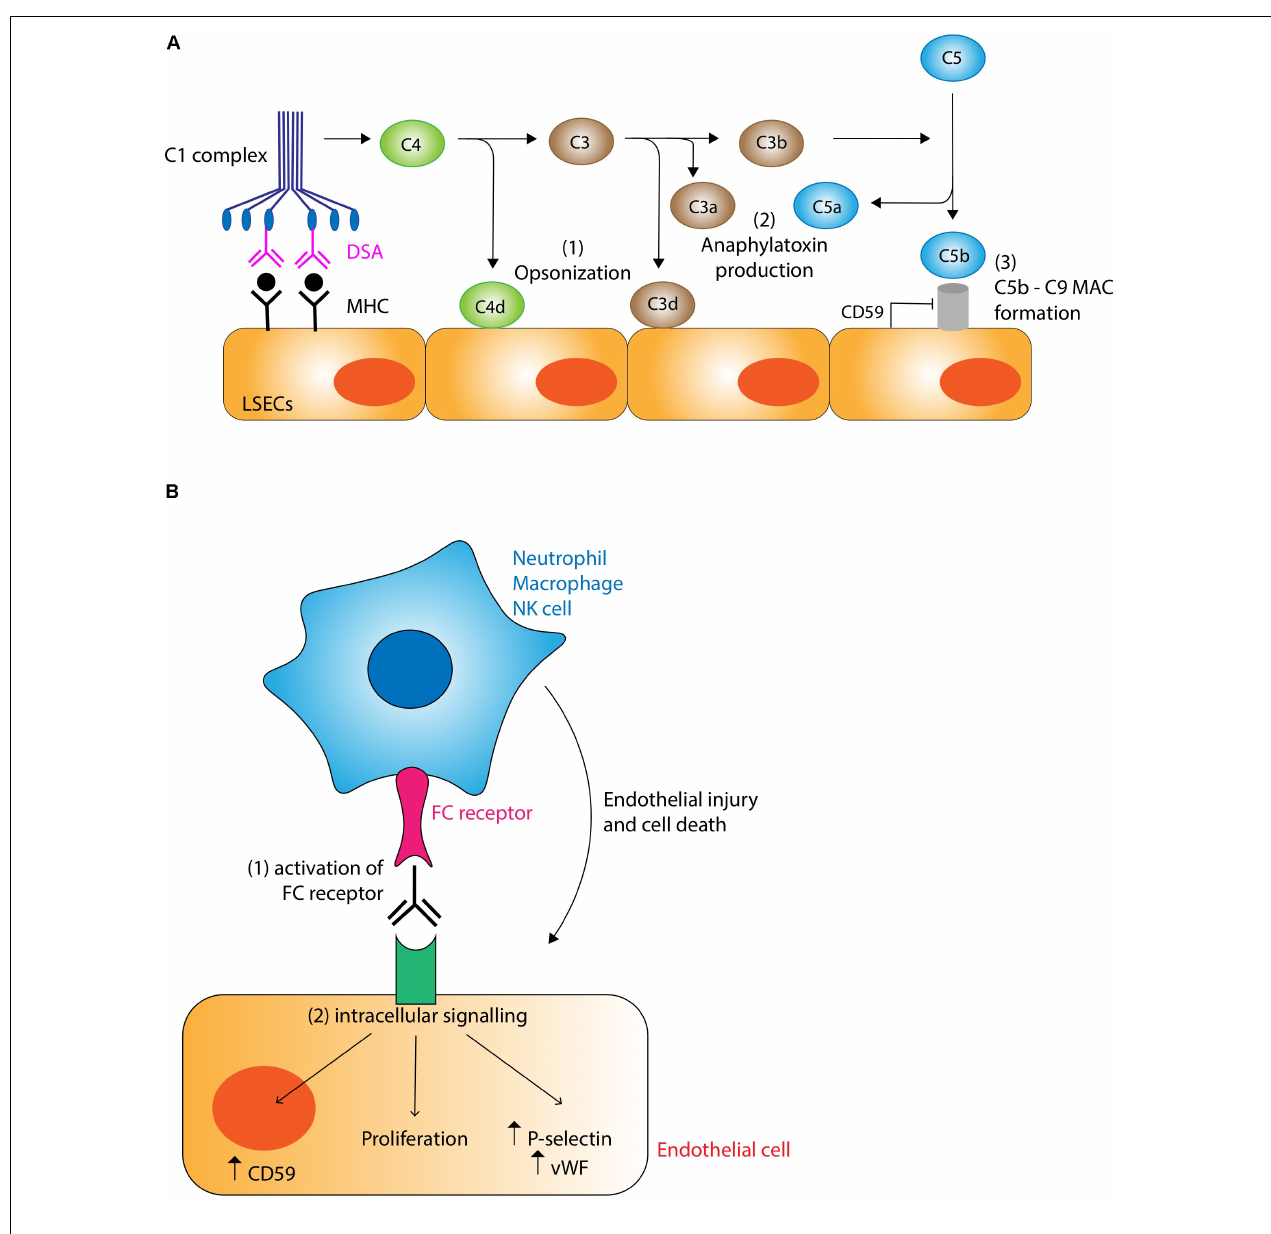
FIGURE 3 | (A) Complement-dependent mechanisms of antibody mediated rejection. Binding of donor specific antibody (DSA) to MHC molecules on the liver allograft causes activation of the classical pathway of complement via binding of the C1 complex. Complement has the potential to damage the graft through three main mechanisms: (1) Opsonization. C4d and C3d covalently bind to target cells marking them for destruction and clearing by cells of the innate immune system. (2) Anaphylatoxin production. C3a and C5a act as potent chemotactic signals recruiting inflammatory cells which cause localized tissue damage. (3) Membrane attack complex (MAC). The C5b-9 MAC has the potential to damage cells by puncturing holes in the membrane, although this action is normally inhibited by endothelial expression of CD59 (protectin). Non-lytic binding of the MAC induces endothelial upregulation of pro-inflammatory, lymphocyte recruitment, and MHC